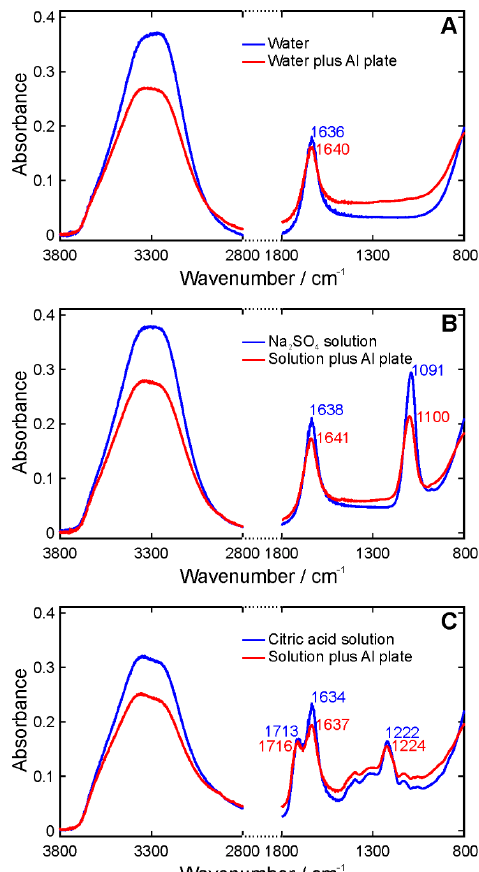
Figure 2. Fingerprint and hydroxyl (OH) stretching region of the IR spectra recorded with and without aluminum plate. ( A ): water; ( B ): aqueous sodium sulfate solution; and, ( C ): aqueous citric acid solution.